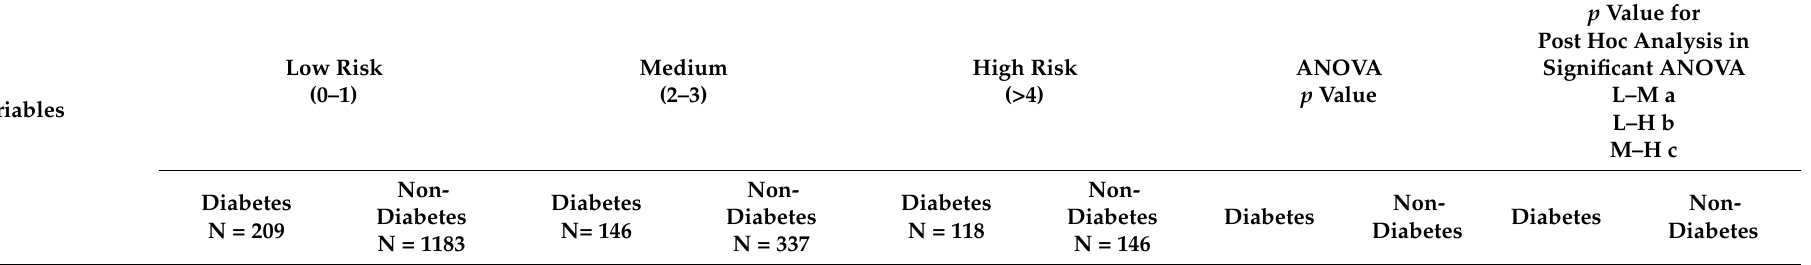
Table 3. Applied treatment and procedures in the diabetic and non-diabetic cohorts after C 2 HEST risk